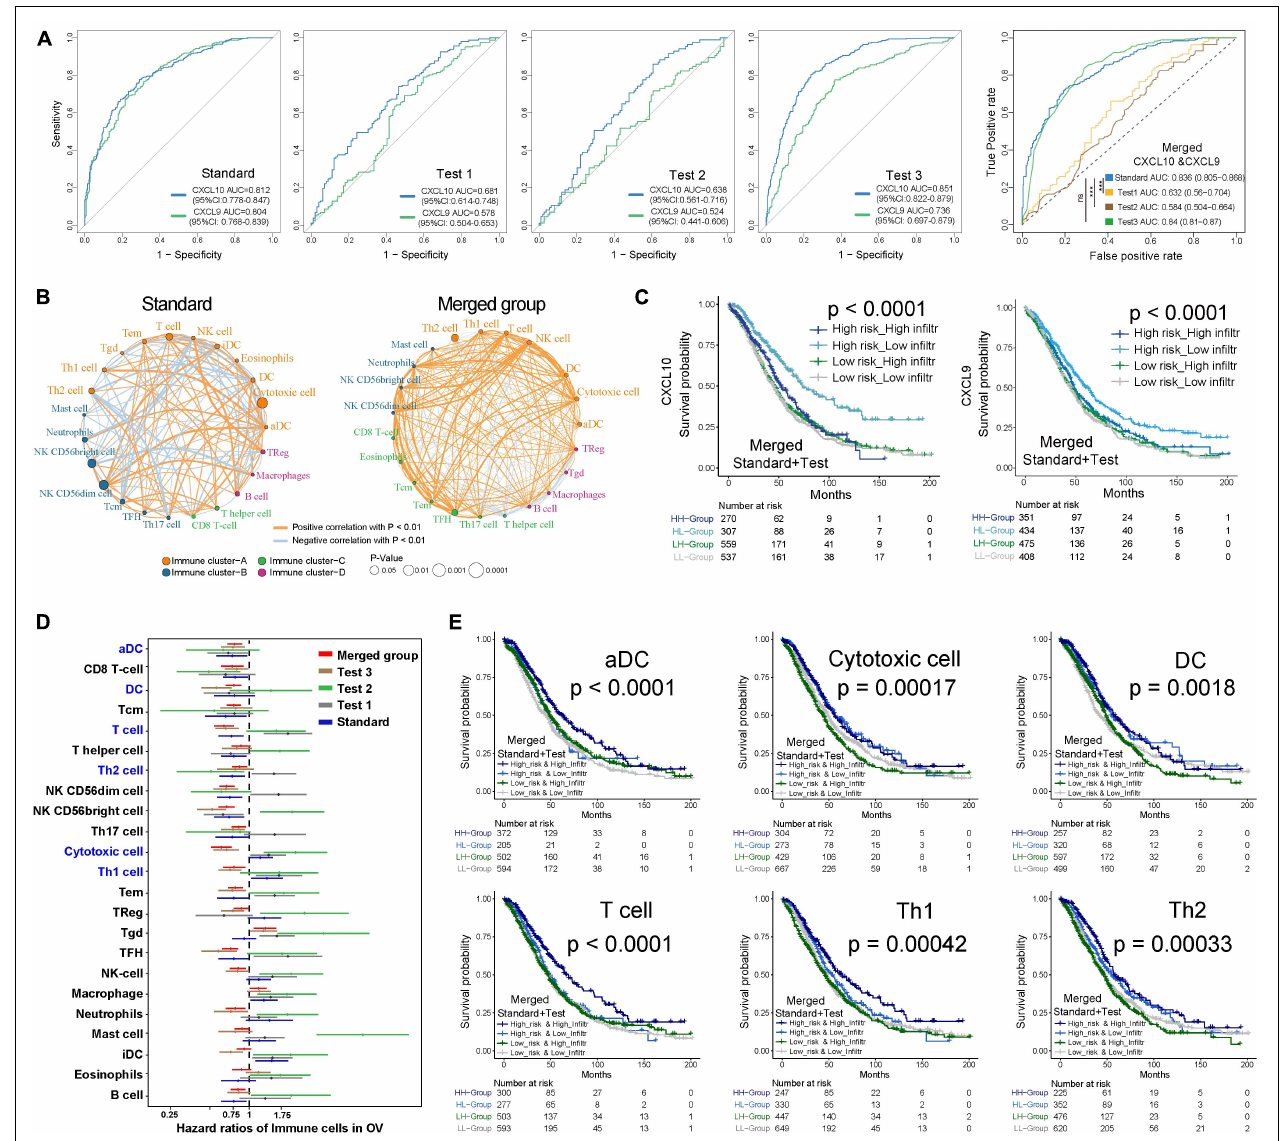
FIGURE 2 | Kaplan-Meier survival analyses of TME cell infiltration and in distinct risk classification. (A) ROC curves measuring the predictive value of the CXCL10 and CXCL9 in high/low risk of immune infiltration of ovarian cancer. In four independent groups (Left), blue line represented the CXCL10 and green lines represented the CXCL9. Comparison of ROC curves for the ability of the combined-CXCL10/CXCL9 to estimate infiltration level of four group of ovarian cancer datasets (Right). (B) The interaction between TME immune cell types in standard cohort (left) and merged sample (right). The strength of correlation was presented with thickness of lines, and positive correlation is marked with orange and negative correlation with light-blue. Red dot represented favor for OS, and black dots represented risk for OS. Four immune clusters were presented, namely, clusters (A–D). (C) Kaplan-Meier curves for the merged patients with complete information in ovarian cancer were stratified by both CXCL10/CXCL9 risk classification (high/low) and TME infiltration cluster (high/low) (Log-rank test, P < 0.0001). (D) Prognosis analyses of difference TME immune cells in ovarian cancer. Estimated survival-cut point in each subset of five groups was plotted with 95% confidence intervals (CI) lines. (E) Kaplan-Meier curves based on the prognosis of infiltration (high/low) and CXCL10 risk classification (high/low), infiltration impact was defined in panel (D) in all tumor samples. Six types of immune cells (T cells, DCs, aDC, Th1, Th2, and Cytotoxic cells) were selected. P values were indicated in the